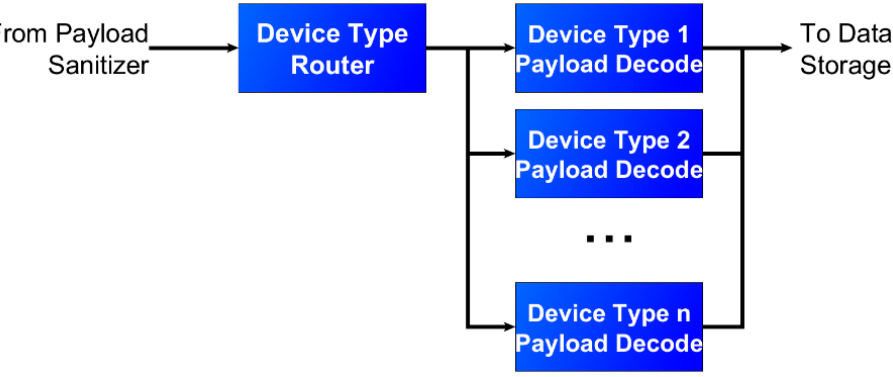
Figure A5. Data flow for payload decoding and conditioning prior to storage for device data inte-